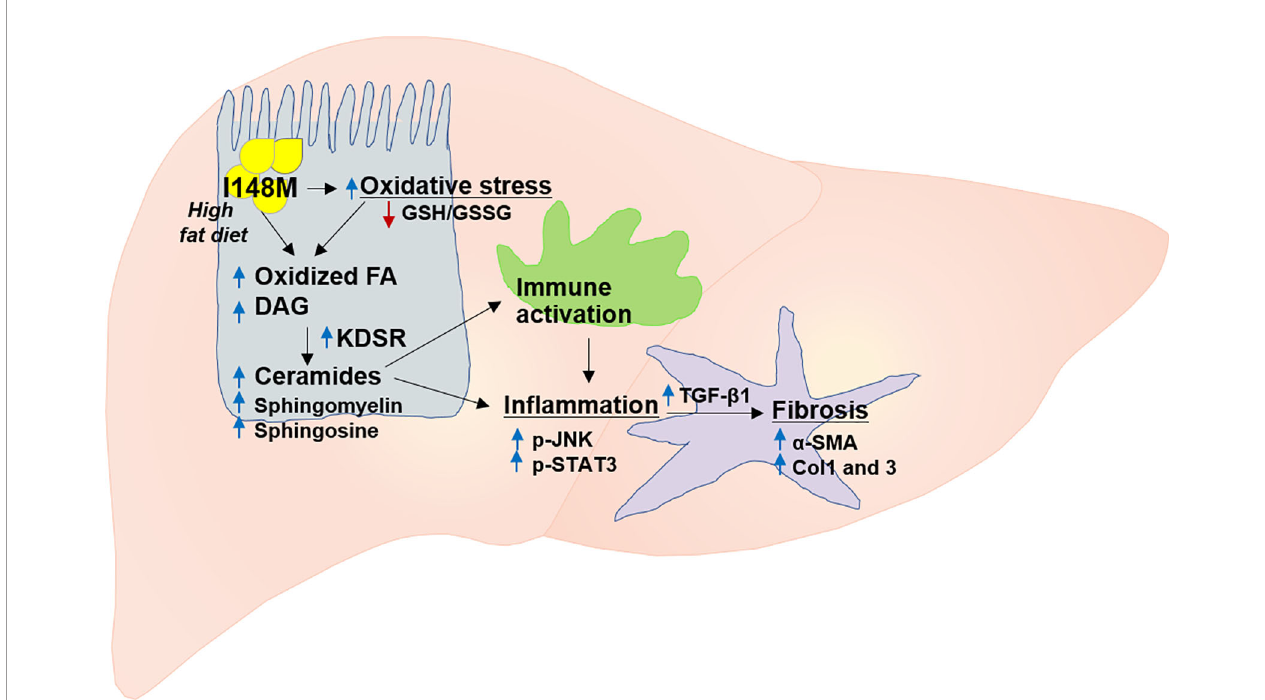
FIGURE 2 | The contribution of mutant PNPLA3 to the risk of NASH and fi brosis. PNPLA3 mutation results in increased oxidative stress and fatty acid oxidation which subsequently leads to accumulation of highly toxic lipid metabolites (e.g. diacylglycerol, ceramides, sphingomyelin, sphingosine). These lipotoxic metabolites trigger immune activation and in fl ammation via key signaling pathways mediated by p-JNK and p-STAT3, and ultimately activation of several fi brogenic pathways such as those for TGF- b 1, a -SMA, Col1 and 3. Col1, collagen I; Col3, collagen III; FA, fatty acid; DAG, diacylglycerol; GSH, GSSG, glutathione-disul fi de; glutathione; JNK, c-Jun activated kinase; KDSR, 3-ketodihydrosphingosine reductase; SMA, a -smooth muscle actin; STAT3, signal transducer and activator of transcription, TGF- b , transforming growth factor b